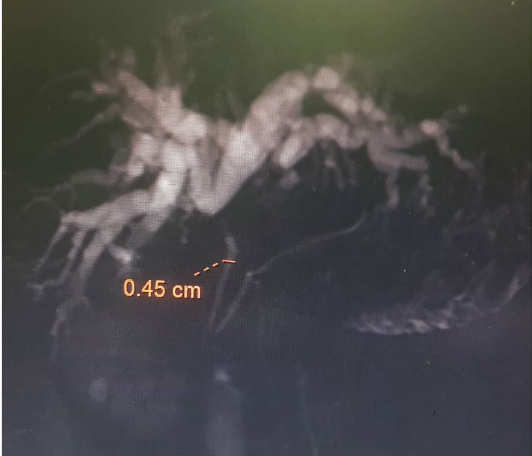
Fig. 1 Bilateral intrahepatic bile duct dilatation, dilated CHD with 1.39-cm length from the confluence and abrupt cut-off end. Drain tube seen in RHD